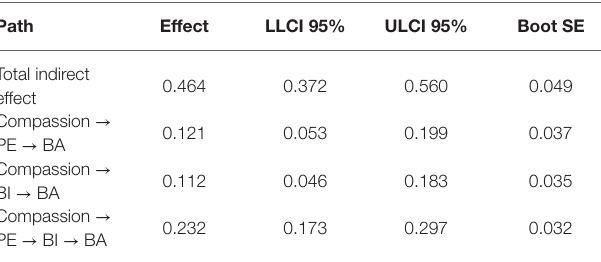
TABLE 5 | Indirect effects for the double mediation effects (positive emotion and brand image).